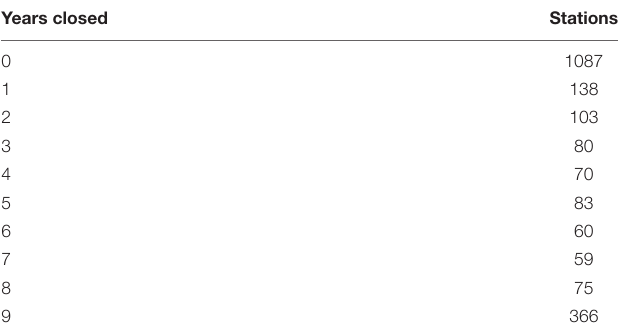
TABLE 1 | The 2,121 water quality monitoring stations from the Virginia Division of Shellfish Safety were classified as closed or open for shellfish harvesting each year from 2012 to 2020 and the total number of years they were closed were